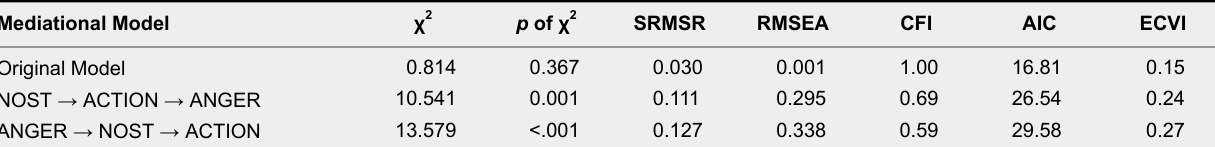
Comparison of Alternative Mediational